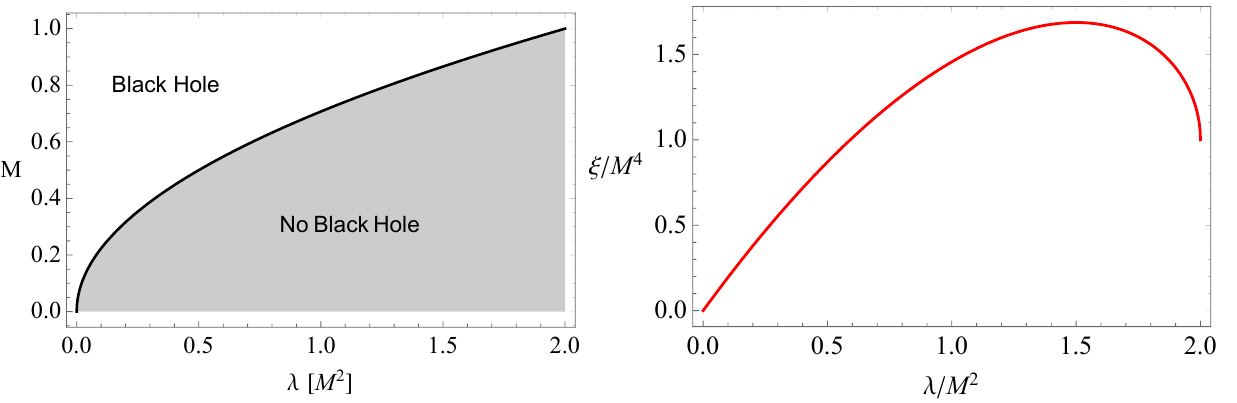
Figure 1. Left panel : The plot shows the metric function for different values of λ . Right panel : The plot shows the two horizons by varying λ while keeping M = 1. The two horizons coincide at λ c .